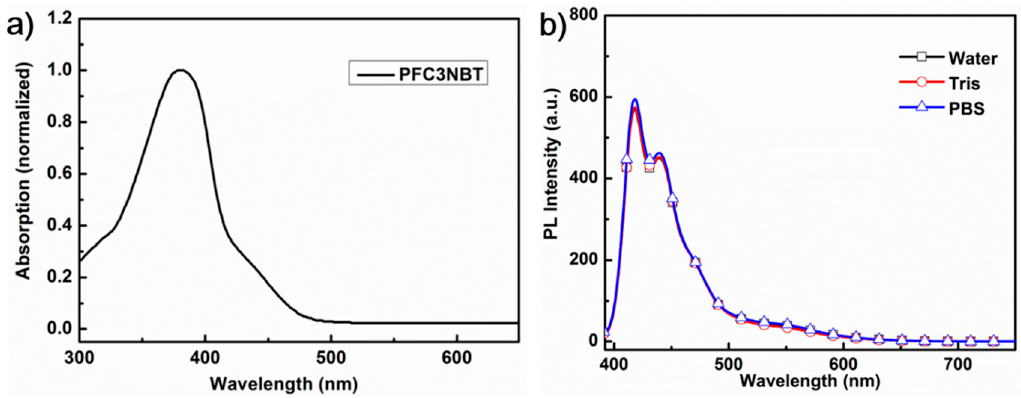
Figure 1. Normalized UV-Vis absorption spectrum of PFC3NBT in water ( a ) and PL spectra of PFC3NBT at RU = 4.5 μ M in water (black), Tris HCl (red) and PBS, pH = 7.4 (blue); ( b ) (excitation at 380 nm).